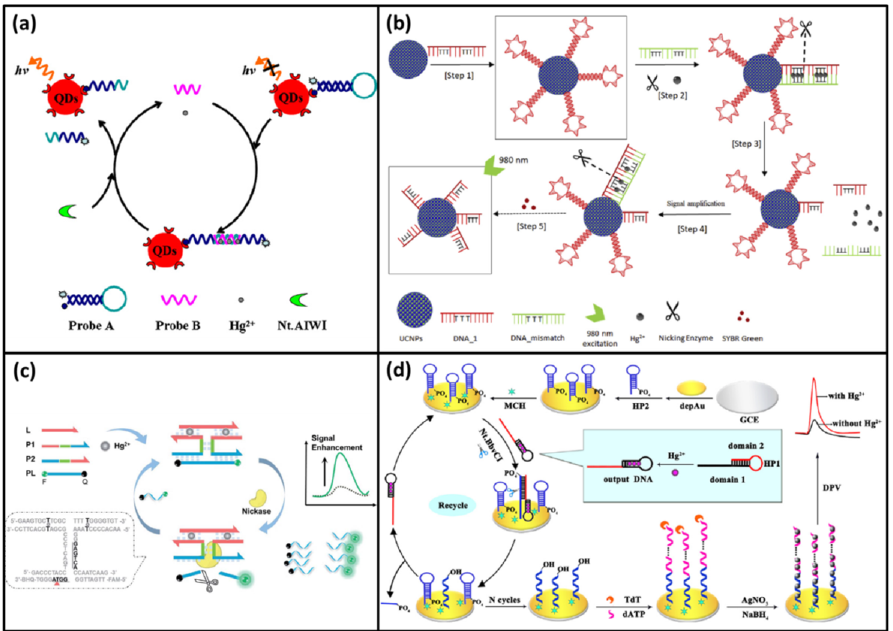
Figure 5. ( a ) A scheme of a nicking endonuclease assisted signal amplification for Hg 2+ detection based on quantum dots. Reprinted with permission from ref. [65]. Copyright 2013 Elsevier. ( b ) A scheme of a highly sensitive biosensor for Hg 2+ detection based on luminescence resonance energy transfer (LRET) between nanoparticles and SYBR Green I. Reprinted with permission from ref.